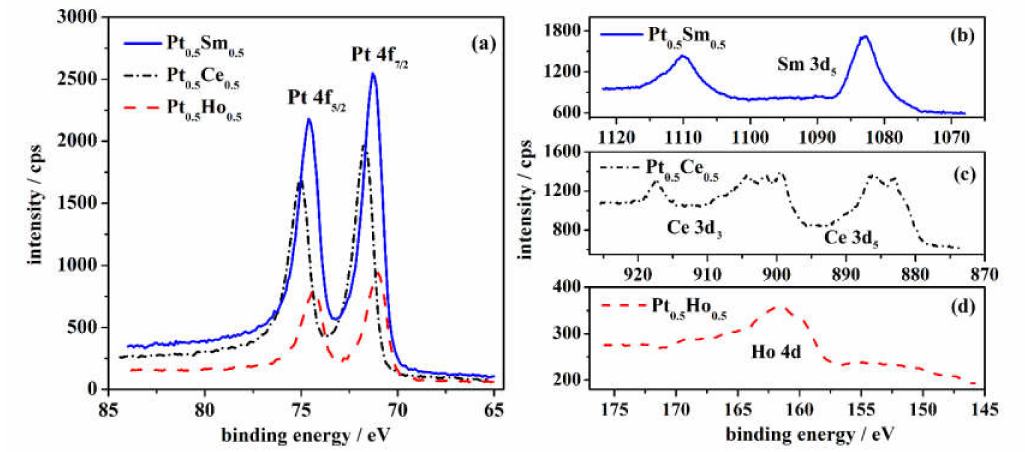
Figure 2. XPS spectra of ( a ) Pt 4f in Pt 0.5 Sm 0.5 , Pt 0.5 Ce 0.5 , and Pt 0.5 Ho 0.5 and of ( b ) Pt 0.5 Sm 0.5 , ( c ) Pt 0.5 Ce 0.5 , and ( d ) Pt 0.5 Ho 0.5 alloys in the standard binding energy range of each rare earth (RE)